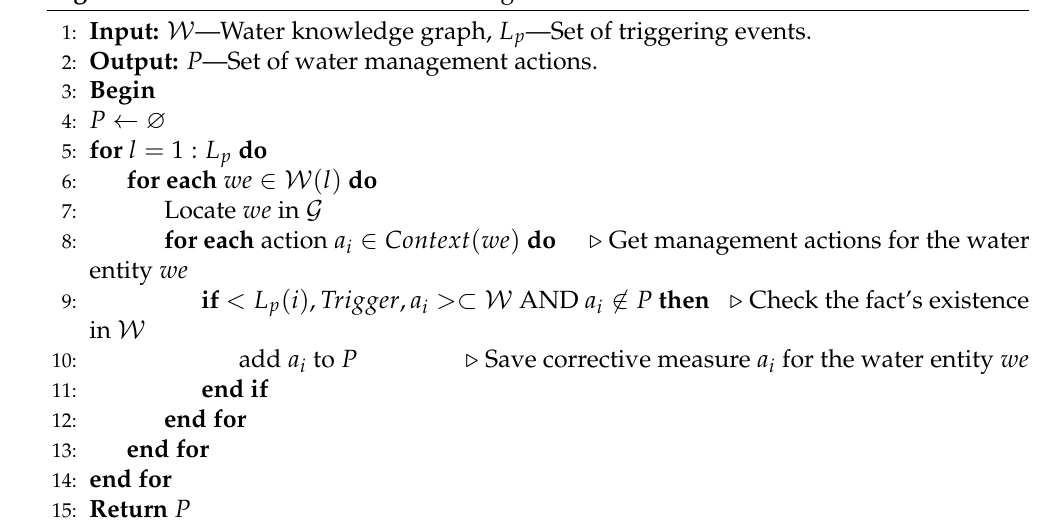
Algorithm 2 Smart water